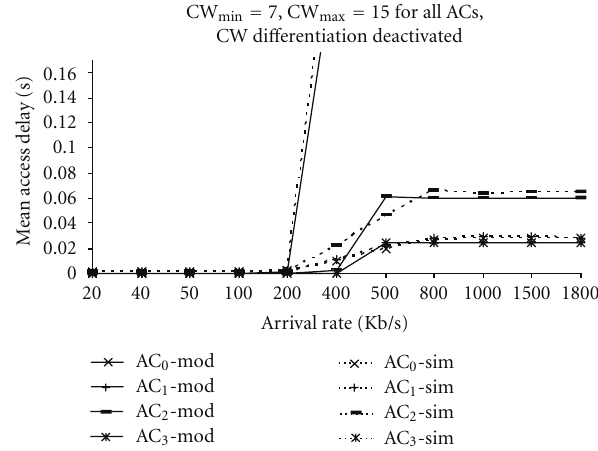
Figure 32: Access delay per AC—CW deactivated.